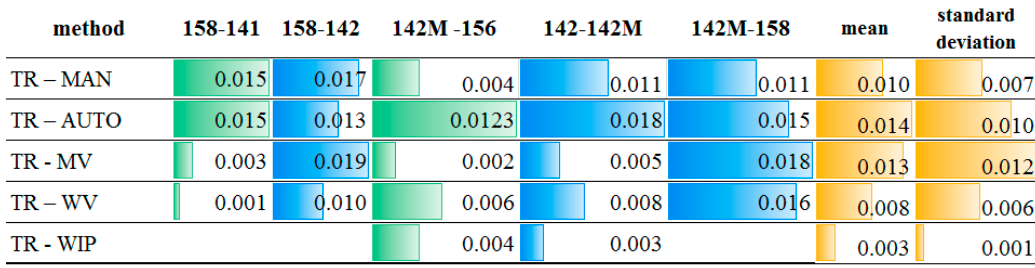
Figure 12. Accuracy check for the chosen targets.